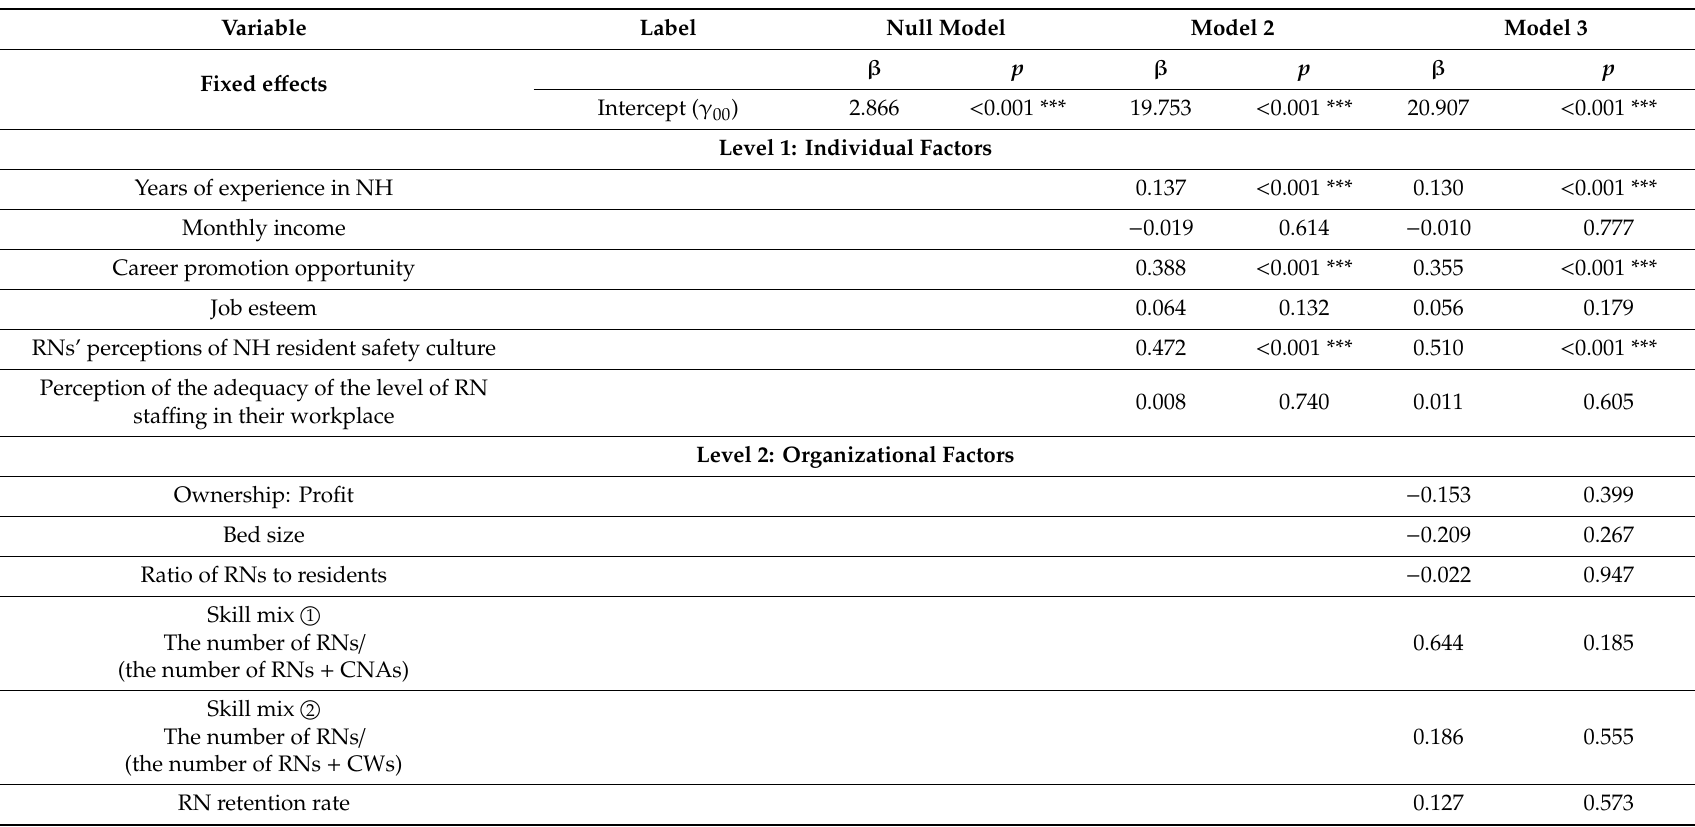
Table 3. Multilevel regression analysis for RNs’ intention to stay in